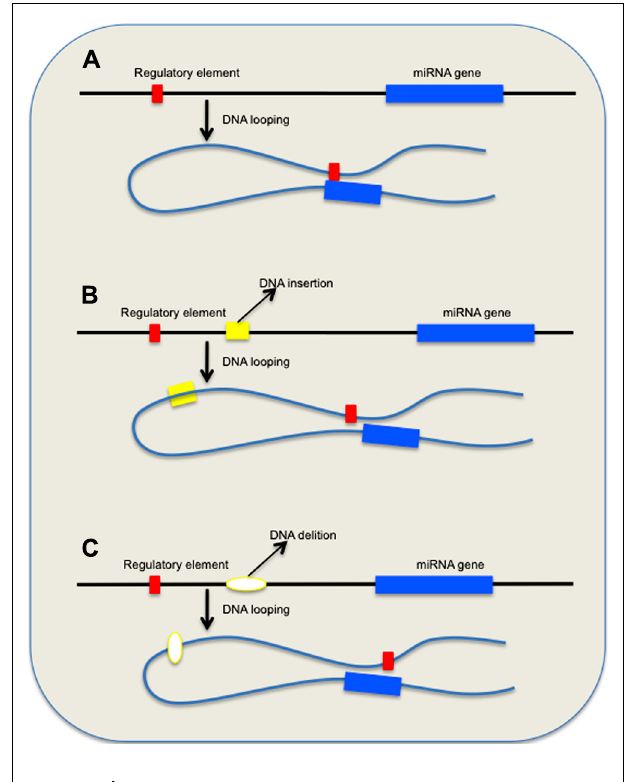
FIGURE 1 | Effect of genomic variations on long-range DNA interactions between remote regulatory elements and miRNA genes. (A) DNA looping allows factors associated with distant regulatory element(s) to bind miRNA consensus sequences and control gene expression. (B,C) Scenarios that depict the effect of DNA insertions and deletions on the repositioning of the remote regulatory element(s) and eventual loss of physiological control